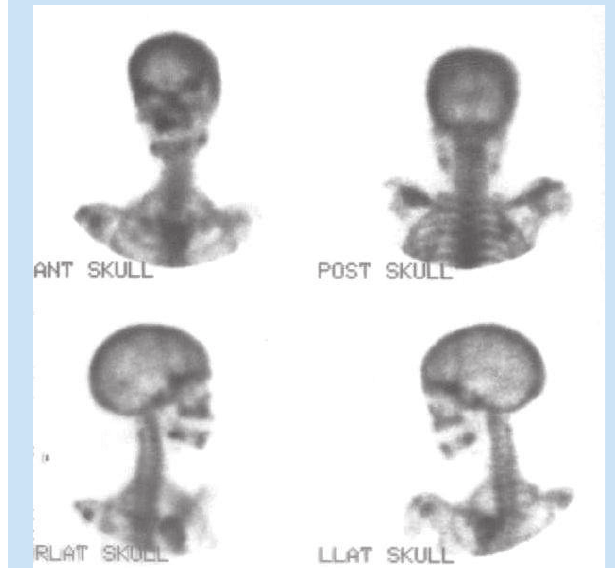
Fig. 1. Involvement of maxilla, mandible and skull base on bone scan.